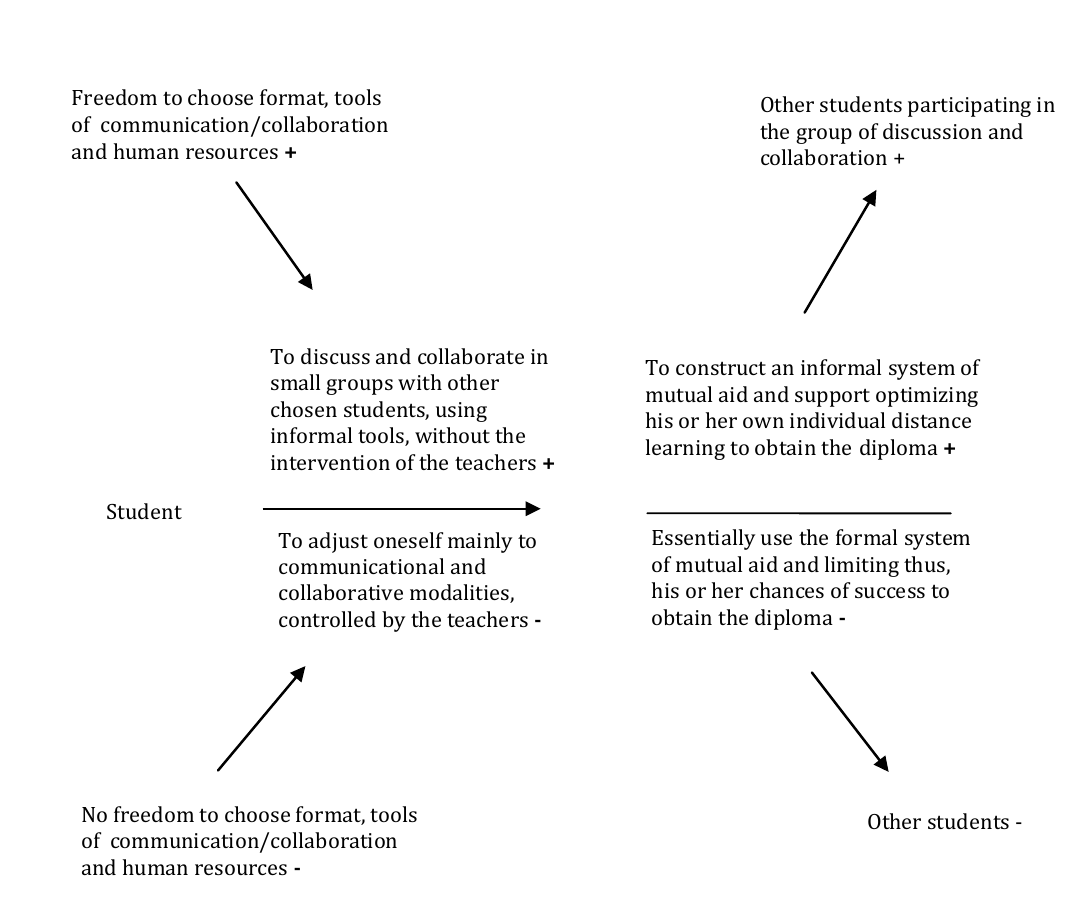
Figure 8 . Synthetic meaningful actantial schema illustrated students’ creative environmental self-regulated